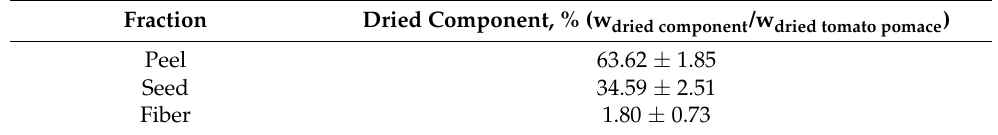
Table 3. Peel, seed, and fiber ratio values determined for the batch of tomato pomace used in the present work. Results are given as % (w dried component /w dried tomato pomace ).